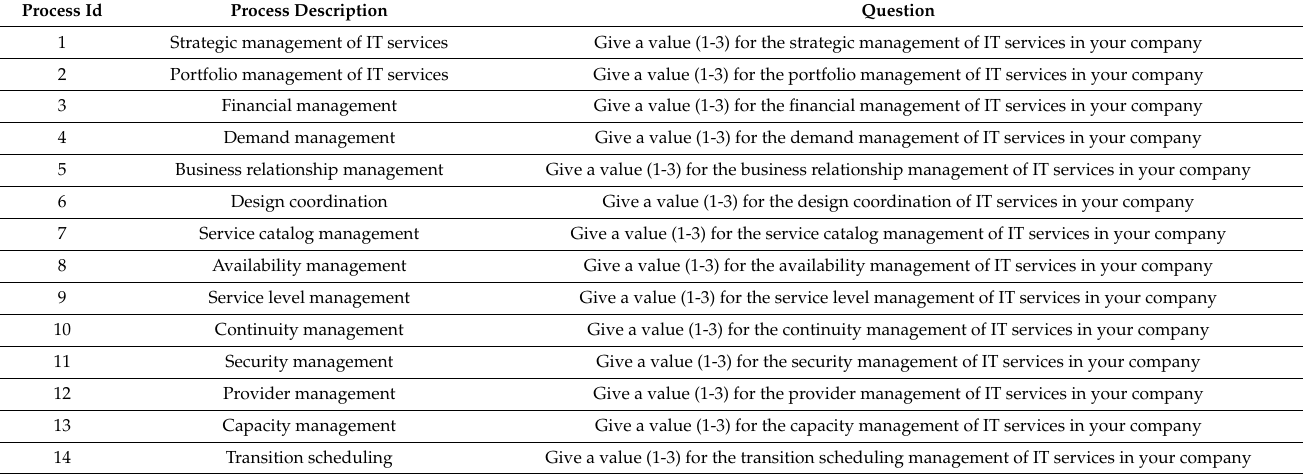
Table A1. Questionnaire used in the survey about ITIL